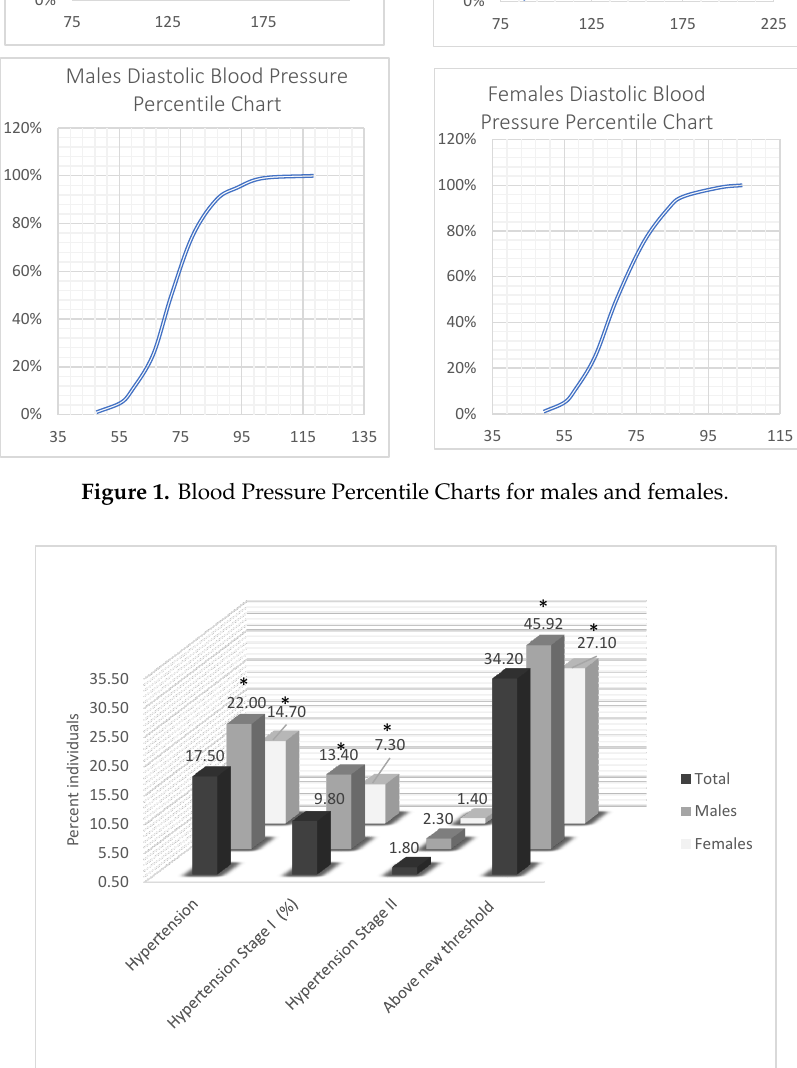
Figure 2. Prevalence of total hypertension; Stage I, Stage II and percent above new recommended